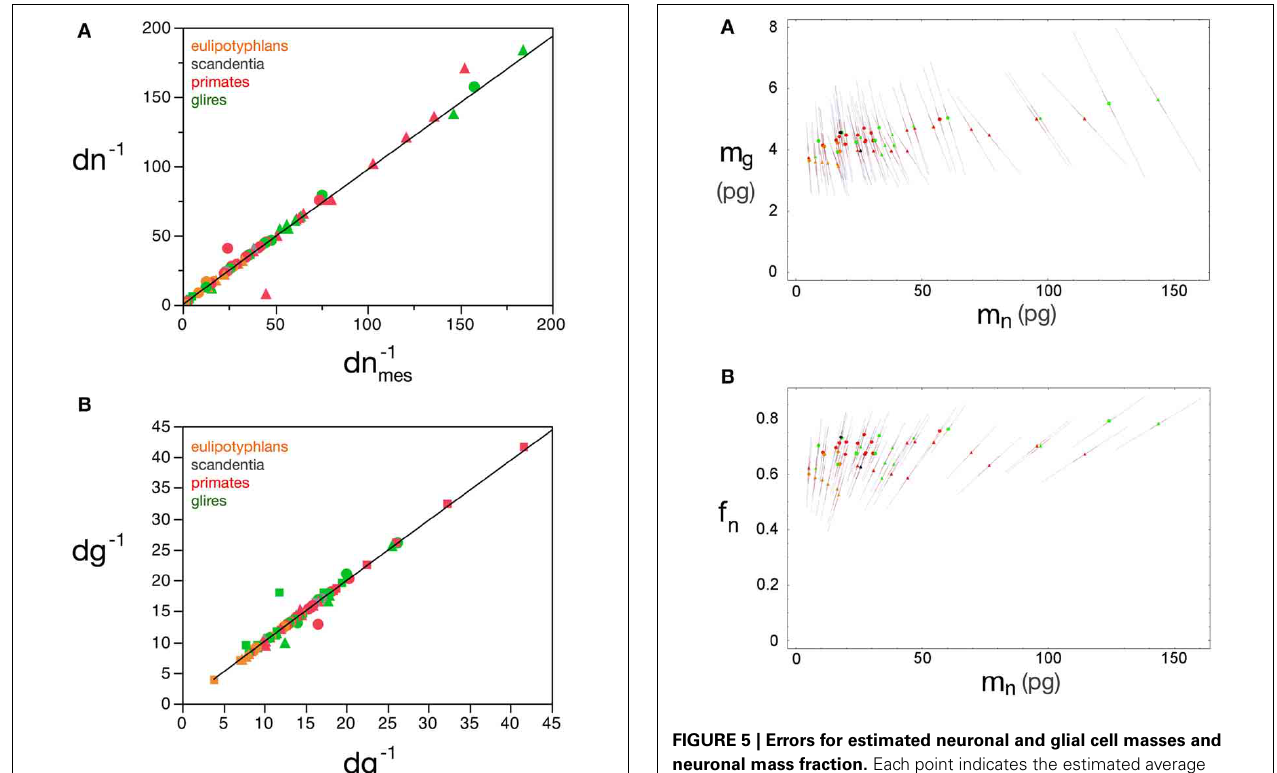
p < 0 . 0001; Figure 9A ) and f g = 2.008 ( d − 1 0 . 906, p < 0 . 0001; Figure 9B ). Using cell densities obtained